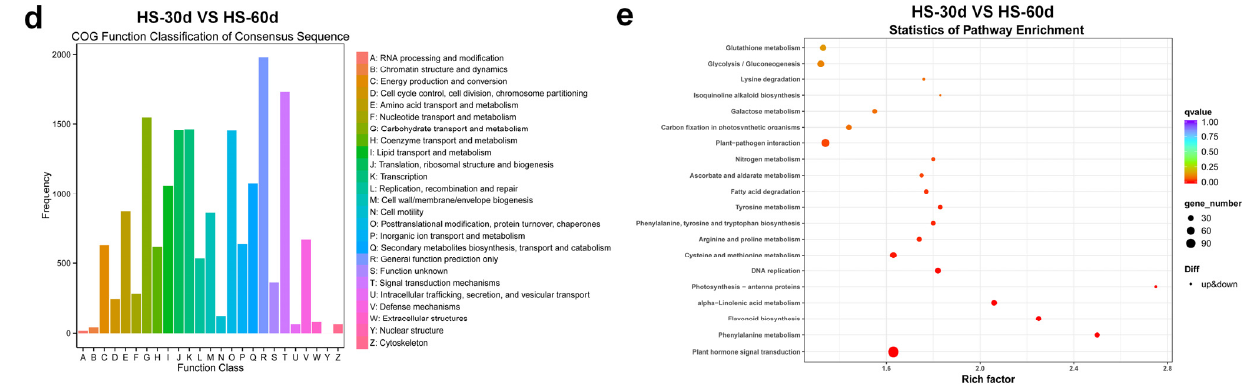
Figure 3. Transcriptome analysis of the DEGs in ‘Huashuo’ fruit flesh. ( a ) Correlation analysis be- tween the six samples (HS-30d, HS-60d, with three replicates). HS-30d: Huashuo fruit at 30DAFB; HS-60d: Huashuo fruit at 60DAFB. ( b ) Volcano plot analysis of DEGs in HS-30d vs. HS-60d. ( c ) Heatmap of the expression profiles of the DEGs identified in HS-30d vs. HS-60d. ( d ) COG annota- tion classification of DEGs. ( e ) KEGG enrichment analysis of DEGs.